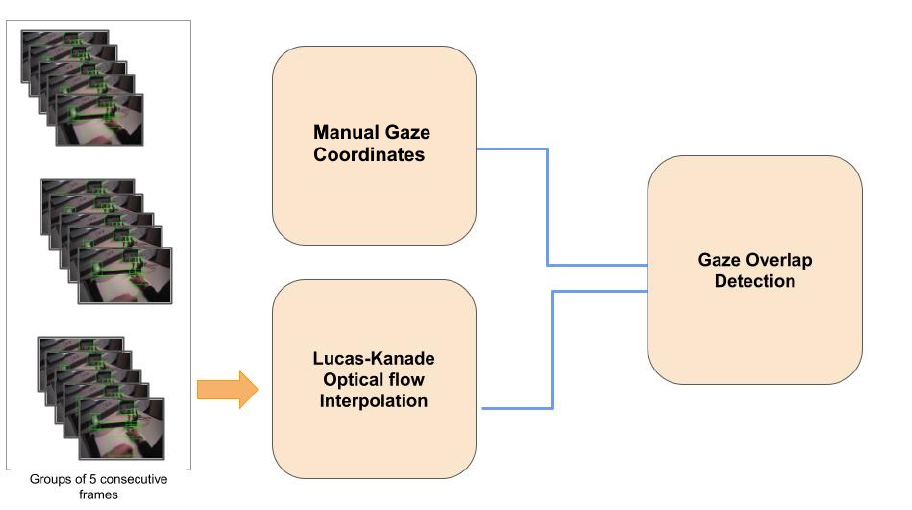
Figure 6. Schematic of the assignment of the manual fixation coordinates to the bounding boxes for five consecutive